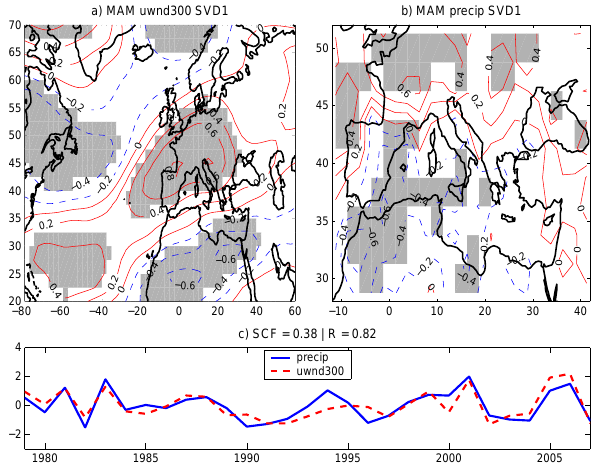
Fig. 10. Same as Fig. 6, but for